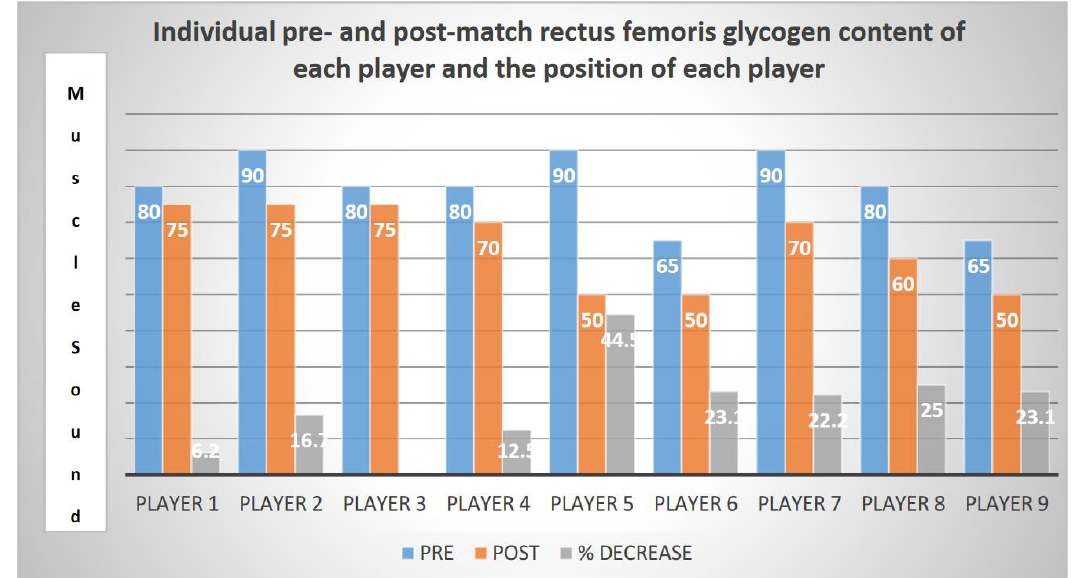
Figure 2. Individual pre- and post-match rectus femoris glycogen content of each player and the position of each player.